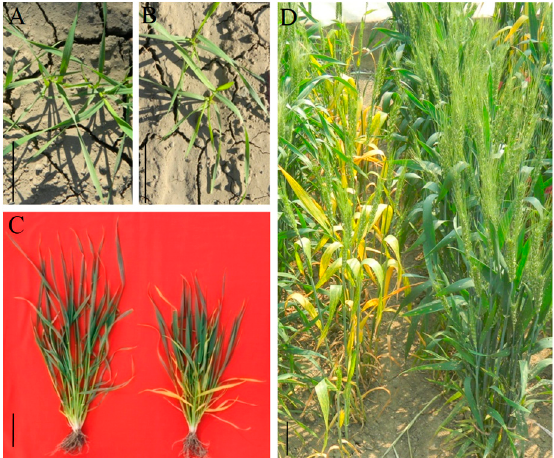
Figure 1. Phenotypic differences between the WT and m68 . ( A ) The wild type (WT) phenotype at the seeding stage ( B ) The m68 mutant phenotype at the seeding stage. ( C ) Leaf phenotypes of the WT (left) and m68 mutant (right) at the shooting stage. ( D ) Filling stage phenotype of the m68 mutant (left) and WT (right). Scale bars = 5 cm.